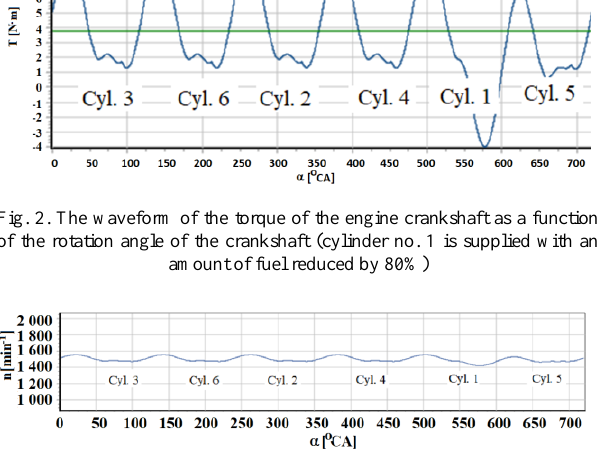
Fig. 3. The waveform of the rotational speed of the engine crankshaft as a function of the rotation angle of the crankshaft (cylinder no. 1 is supplied with an amount of fuel reduced by 80%)